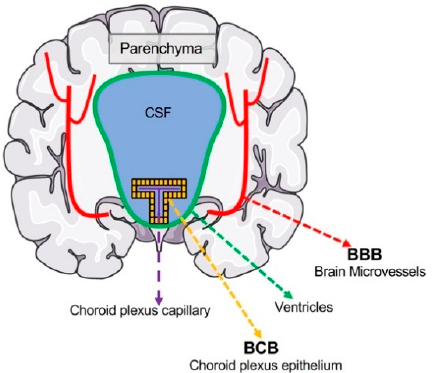
Figure 1. Localizations of the brain barrier interfaces. The blood–brain barrier (BBB) is localized to the microvasculature of the central nervous system and separates the lumen of cerebral blood vessels and brain parenchyma. Neurons and glia are found in the CNS parenchyma and thus protected from the periphery by the BBB. The blood–CSF barrier (BCB) is formed mainly by the choroid plexus epithelium located between choroid plexus capillaries and the CSF. Materials transported through the choroid plexus epithelium reach the CSF, where they can diffuse into the brain parenchyma.